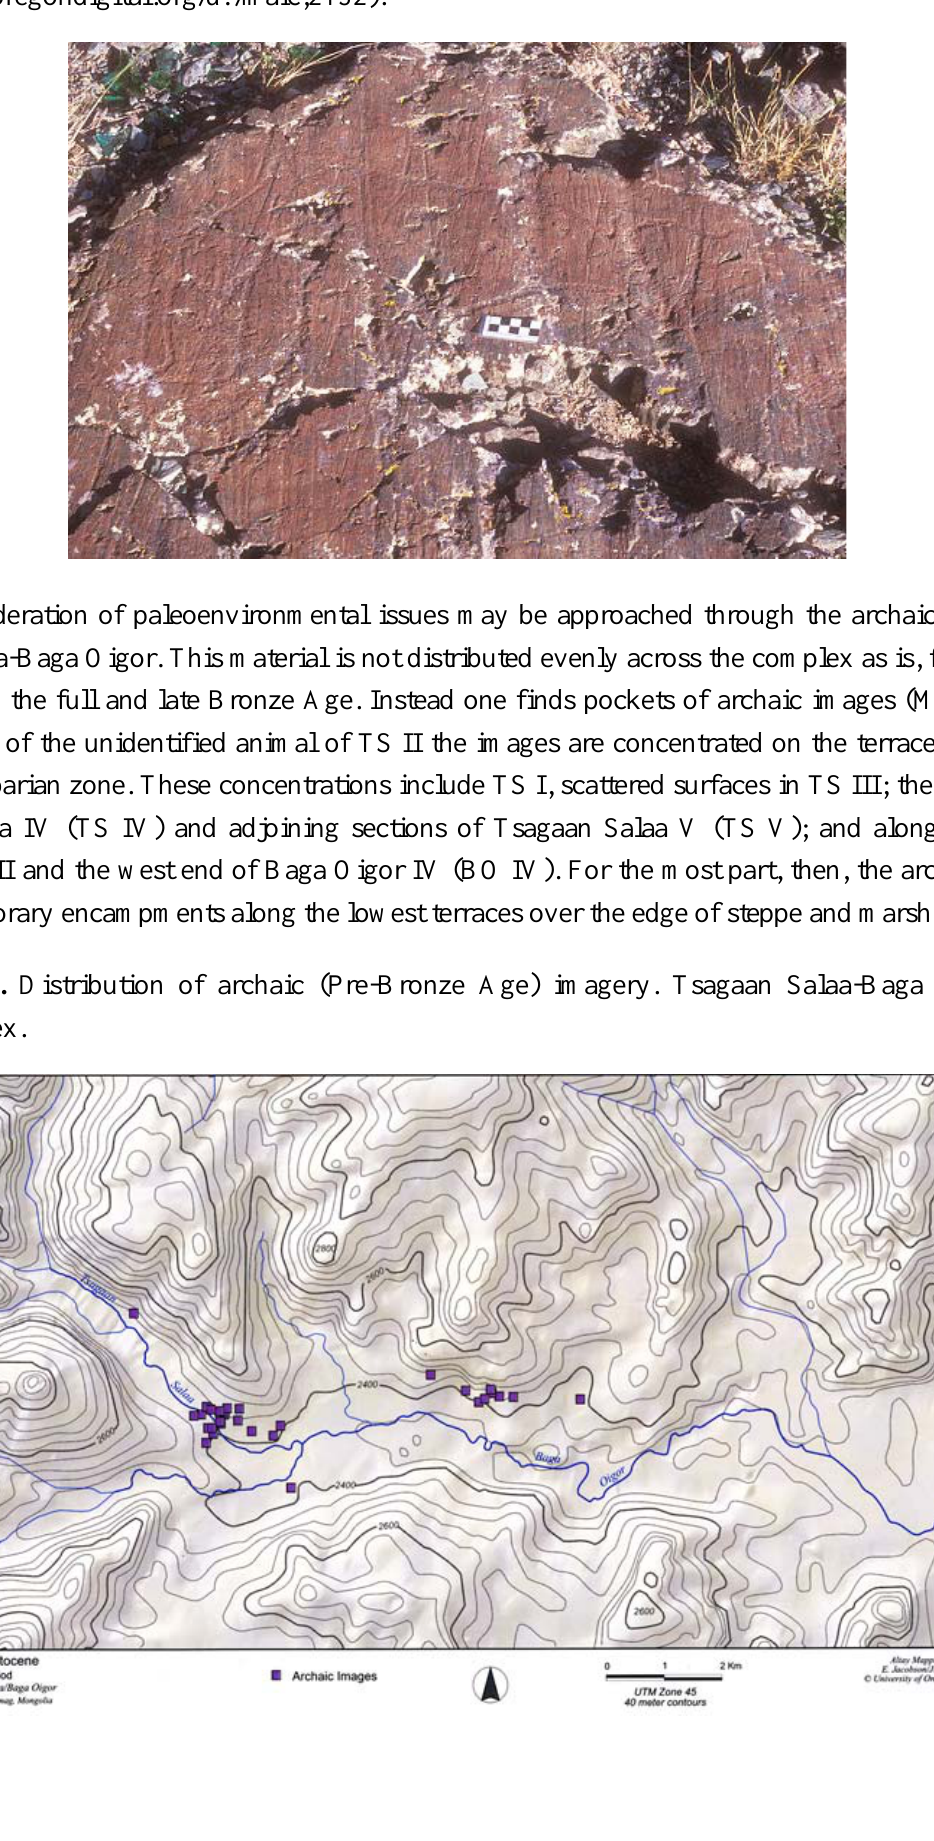
Figure 8. Aurochs and horse on fractured surface. Pre-Bronze Age. Aral Tolgoi.